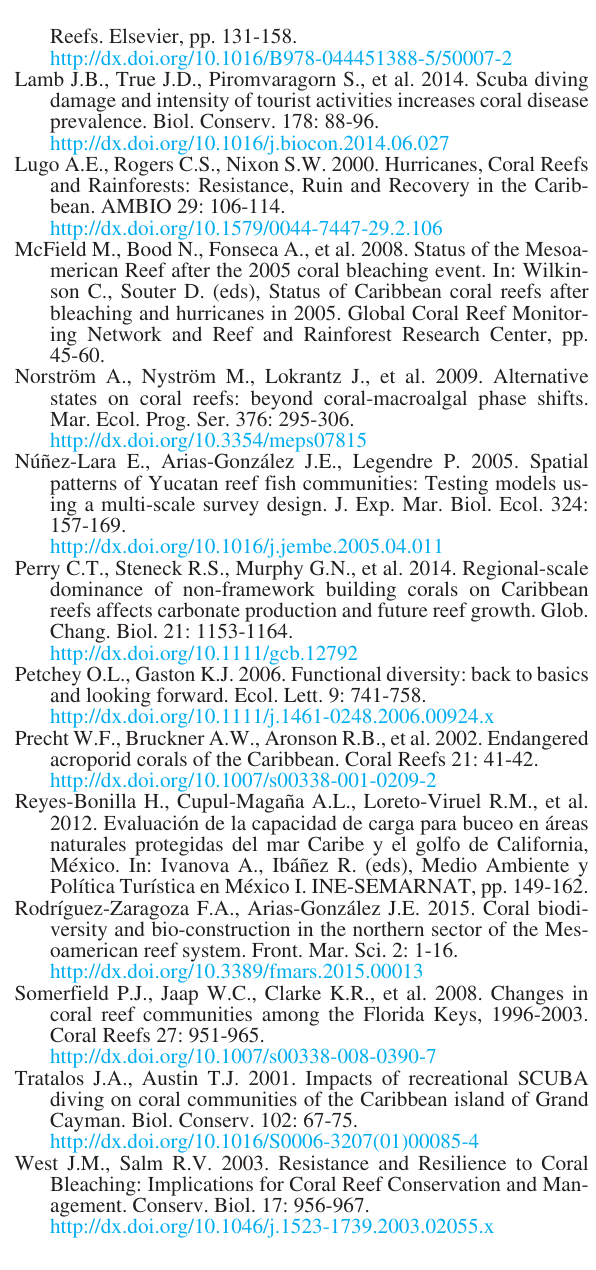
Table S1. – Mean coral cover (± 1SD) of the species recorded in the Cancún National Park. Table S2. – Mean coral cover (± 1SD) of the species recorded in the Cozumel National Park. Table S3. – Ecological indexes of coral assemblages in Cancún Na- tional Park and Cozumel National Park as a function of locality and year. Codes: S is the average species richness; H’ is Shan- non diversity; J’ is Pielou evenness; l is Simpson dominance; LCC is live coral